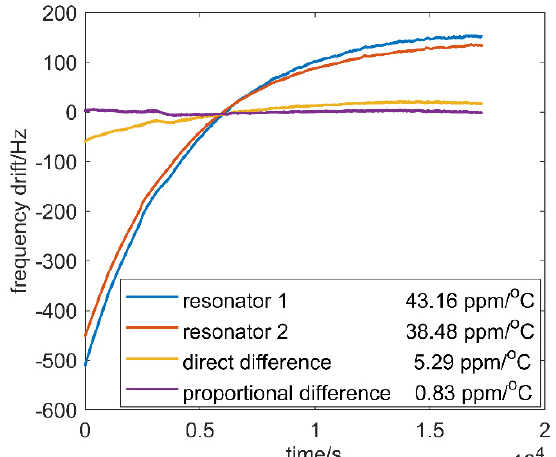
Figure 7. Frequency drift in different cases.